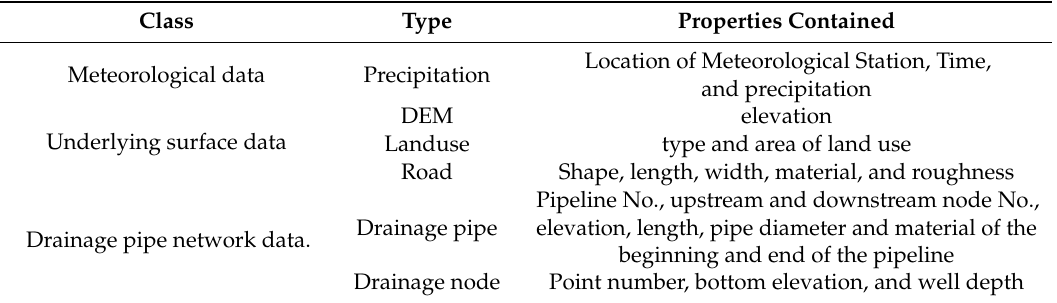
Table 1. Data sources of urban